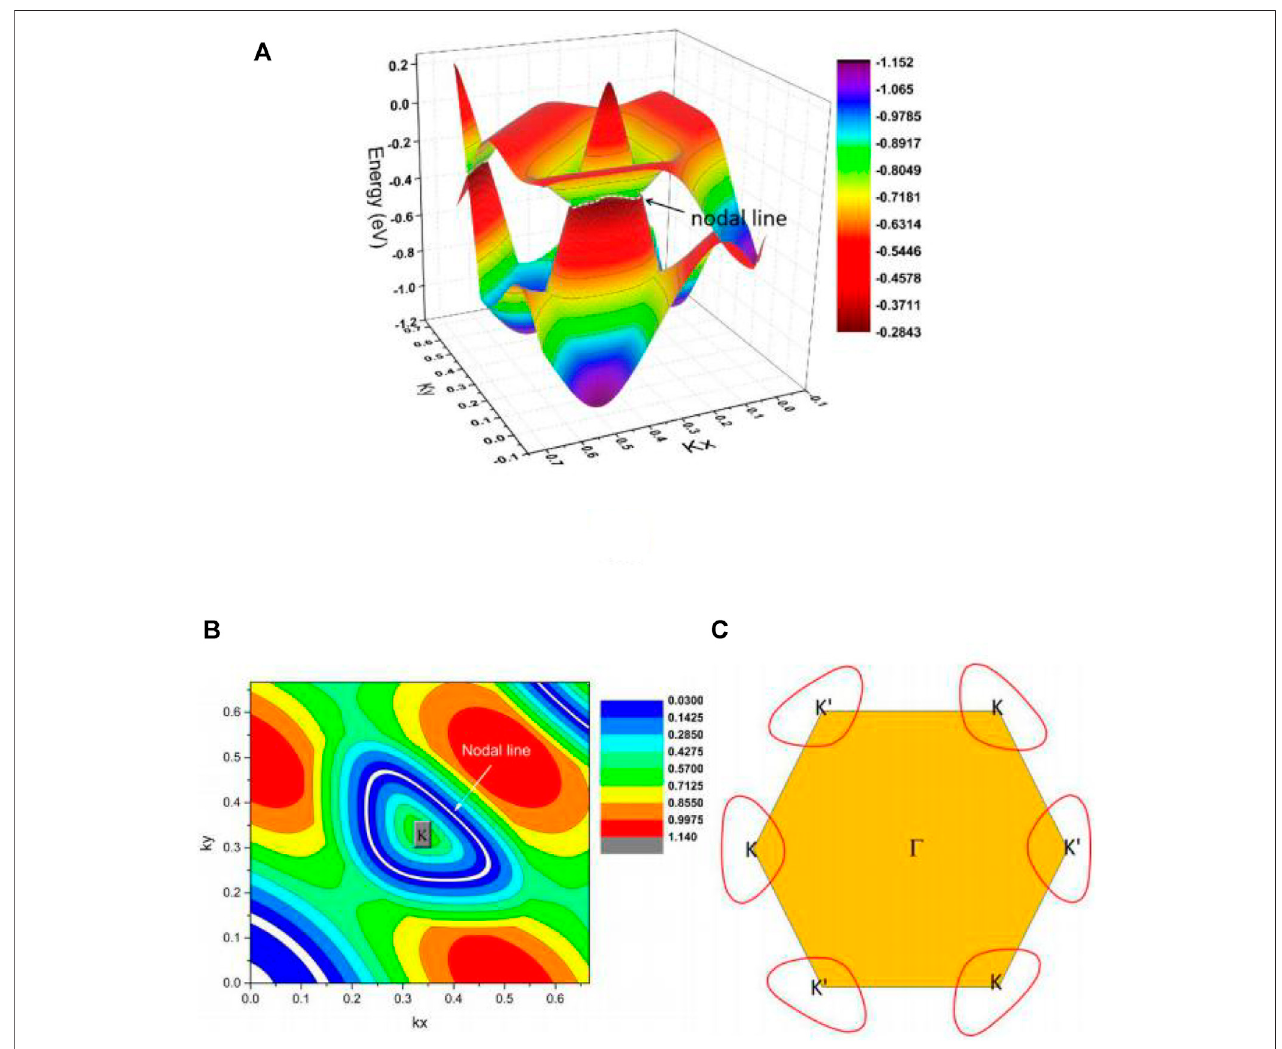
FIGURE5|(A) 3DbanddispersioninregionAofthekz (cid:1) 0plane; (B) theshapeoftheNLinregionAofthekz (cid:1) 0plane;and (C) illustrationofonepairoftypeINLs in the kz (cid:1) 0 plane.